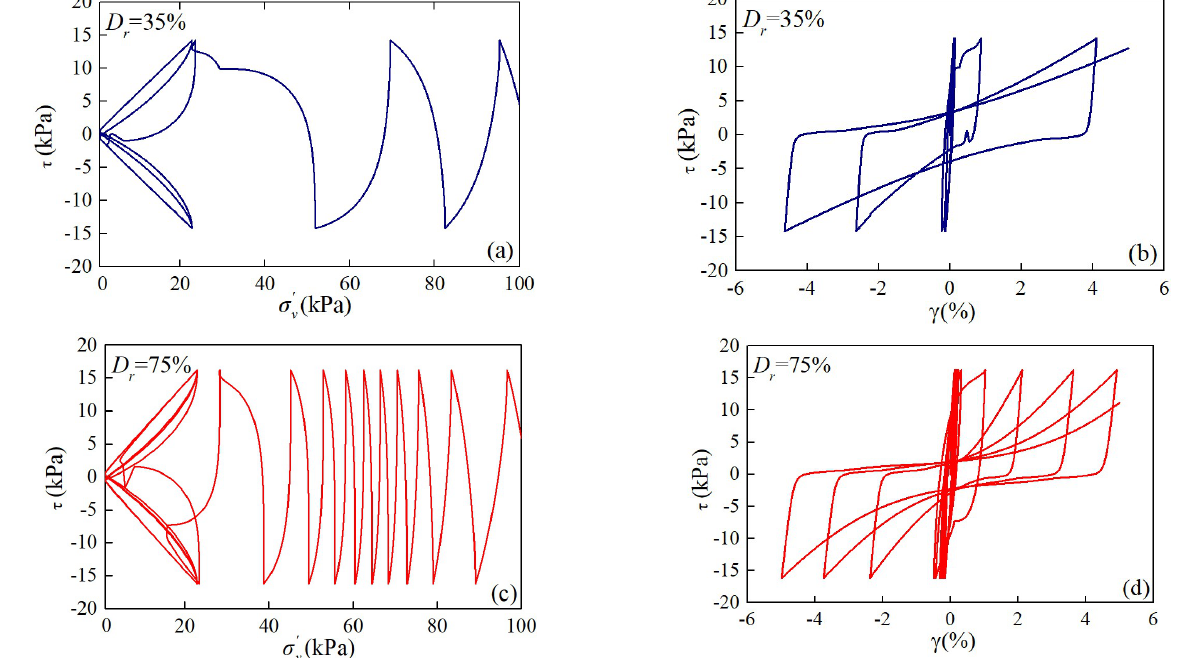
Figure 2. Numerical simulation of response of sand in cyclic DSS element tests: ( a ) simulated shear stress vs. vertical effective stress σ v’ , CSR = 0.14 and D r = 35%; ( b ) simulated shear stress vs. shear strain, CSR = 0.14 and D r = 35%; ( c ) simulated shear stress vs. vertical effective stress σ v’ , CSR = 0.14 and D r = 75%; ( d ) simulated shear stress vs. shear strain, CSR = 0.14 and D r =